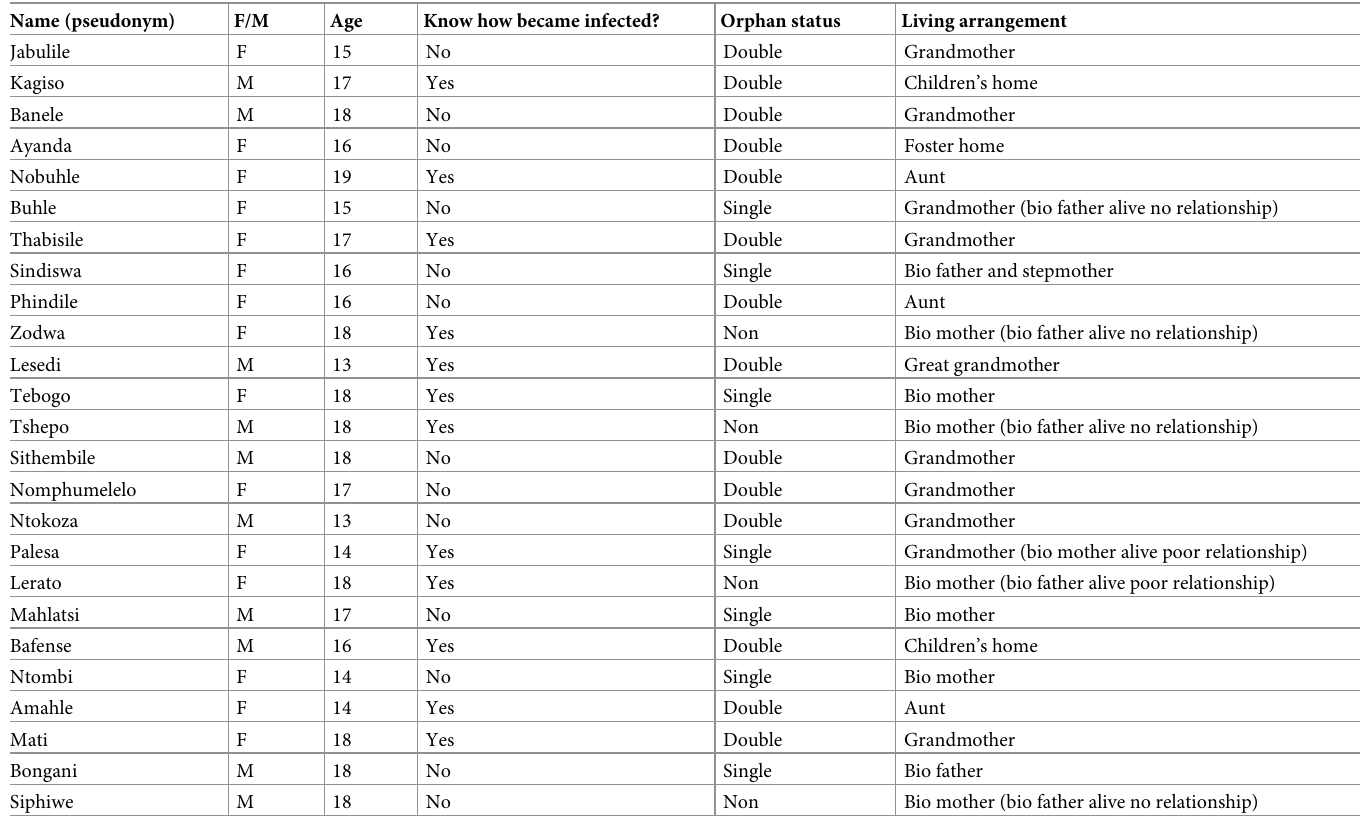
Table 1. Description of the